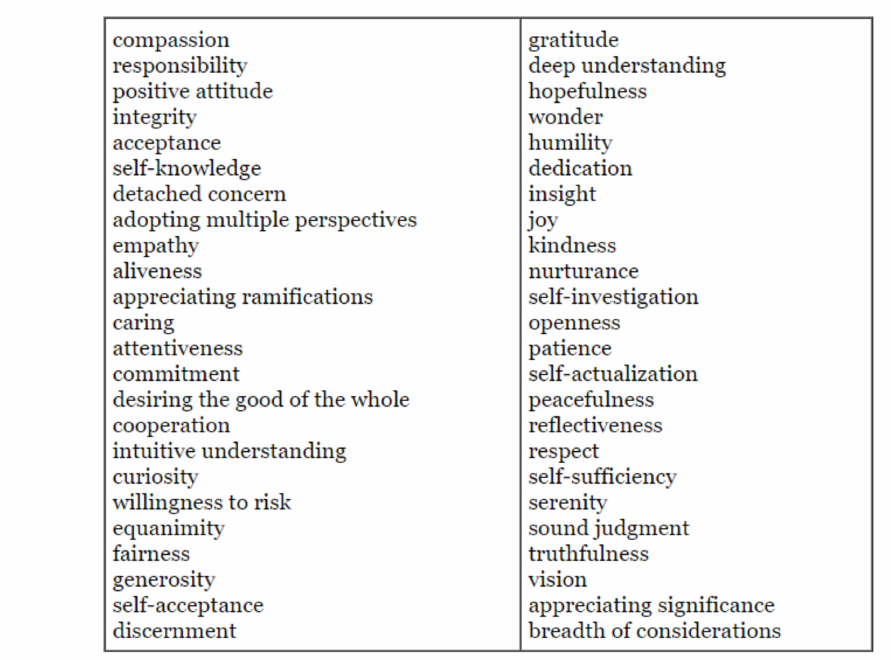
Figure 1. Forty-eight positive human characteristics associated with wisdom (http://www.wisdompage. com/WisdomCharacteristics.html, accessed on 26 July 2021) [Reproduced with